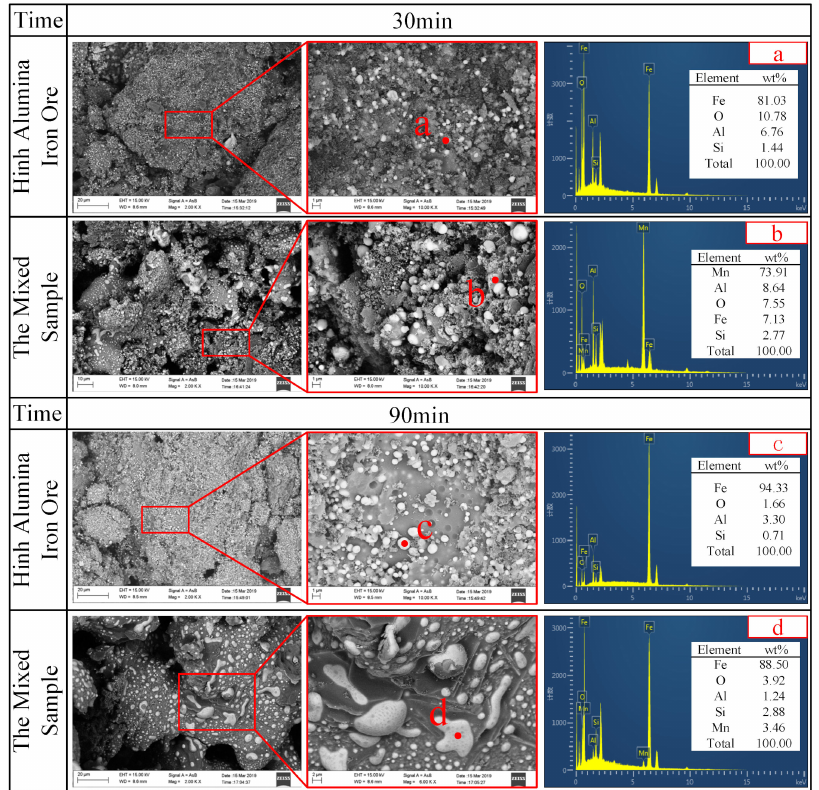
Figure 11. SEM phase analysis for the reduced samples at 1200 ◦ C under FC/O of 1.0 for different reduction times. ( a ) and ( b ) respectively represent The point sweep spectra of High Alumina Iron Ore and The mixed sample with a reduction time of 30 min, ( c ) and ( d ) respectively represent High Alumina Iron Ore and The mixed Sample Point scan spectrum with the reduction time of 90